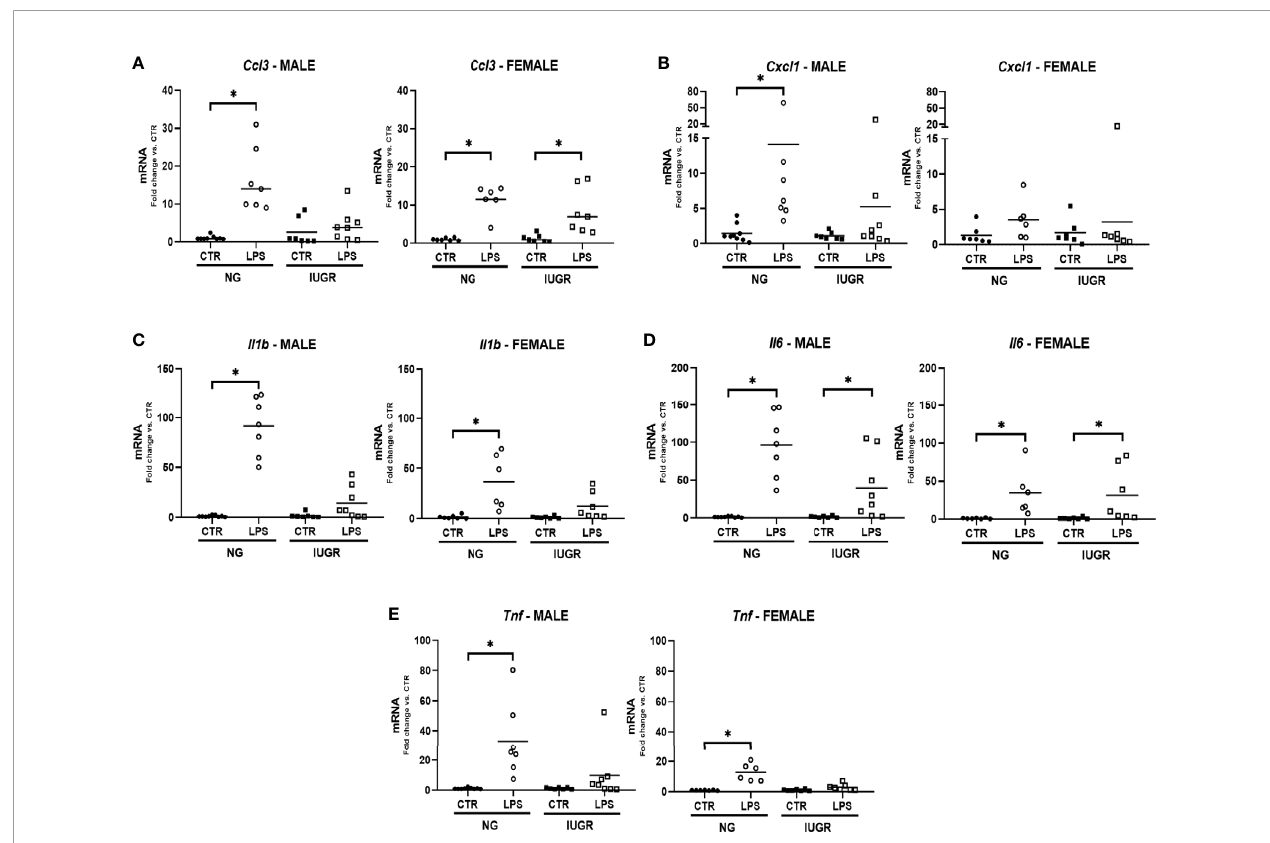
FIGURE 4 | Intra-uterine growth restriction (IUGR) attenuates the hepatic gene expressions of pro-in fl ammatory cytokines in the LPS-exposed neonate. IUGR and normally grown (NG) male and female neonatal (P0) livers were collected and measured for hepatic gene expression of acute pro-in fl ammatory markers (A) Ccl3 , (B) Cxl1 , (C) Il1b , (D) Il6 , and (E) Tnf at 1-hour post IP LPS. * P< 0.05 vs . unexposed (CTR) by the Mann-Whitney test. Values are represented as fold change compared to their respective control